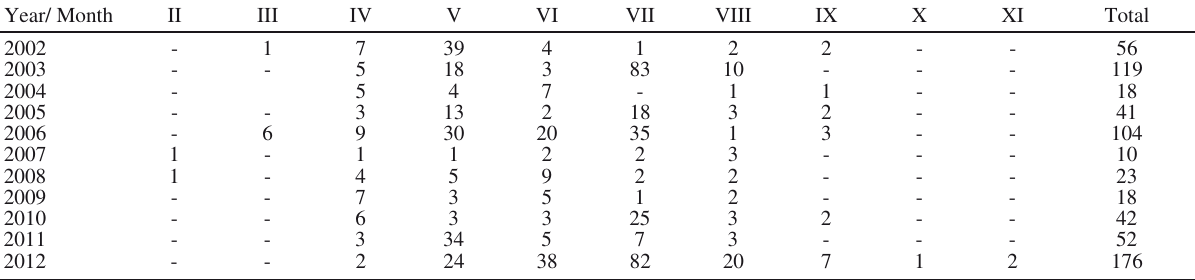
Table 6. – Monthly structure of dolphin strandings on the Romanian coast in